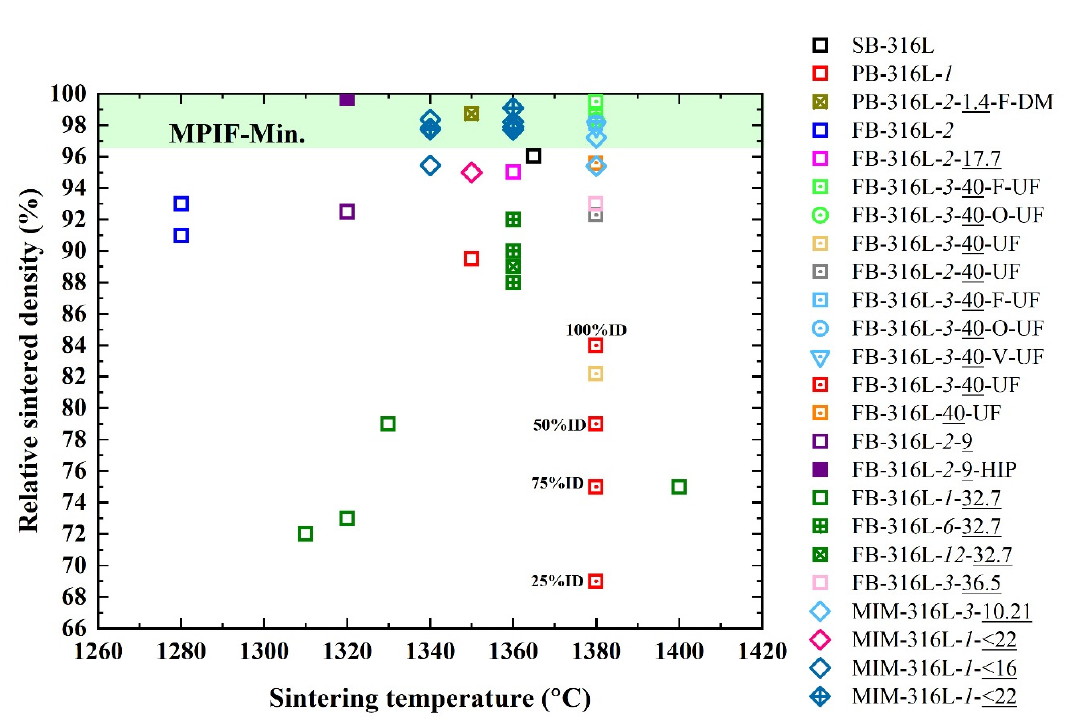
Figure 20. Sintering temperature vs. relative sintered density map of 316L stainless steel fabricated by metal MEX process with different conditions comparing with MPIF standard 35 for MIM materials. The Italic number represents sintering time (h) and the underlined number represents powder size (µm). F, O and V represent flat, on-edge and vertical printing orientations, respectively. ##%ID is the infill density. DM is utilising Desktop Metal system. Data from [9,41,45,52,53,56,57,66,68,70,72,75,81,98,108,159–161,169].